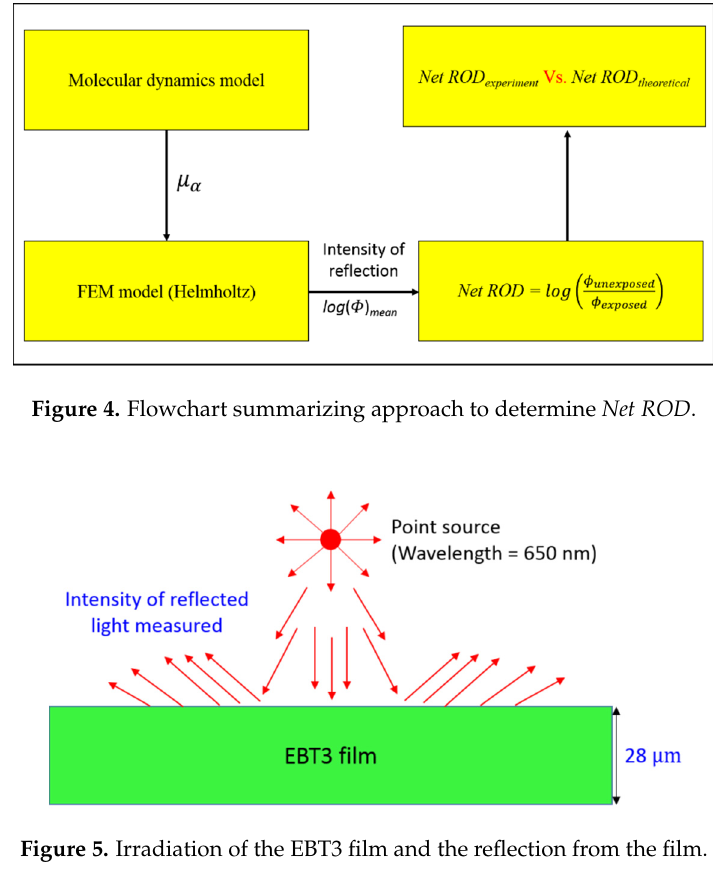
Figure 5. Irradiation of the EBT3 film and the reflection from the film.